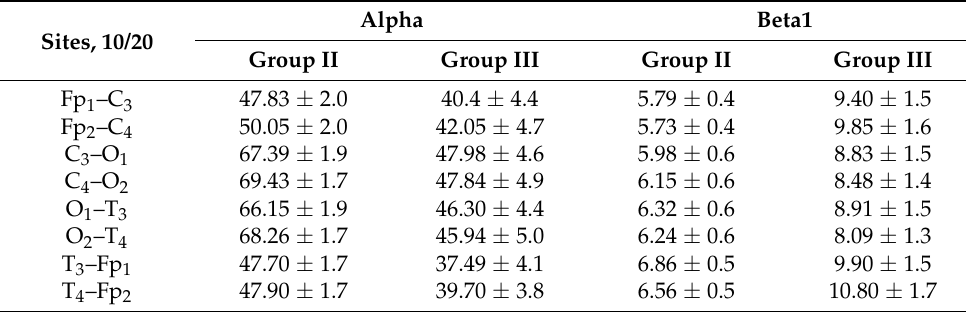
Table 3. EEG power spectra (%) in alpha and beta1